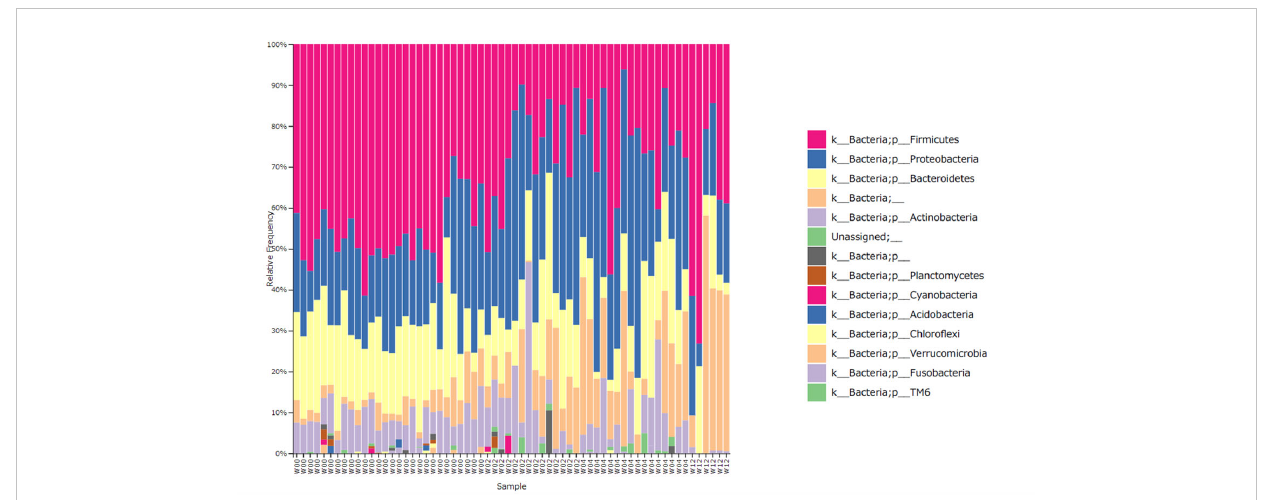
FIGURE 2 Relative abundance of the bacterial phylum level. W00, W02, W04, and W12 represent before operation and 2-, 4-, and 12-weeks after operation, respectively. The proportion of Firmicutes decreased and that of Proteobacteria increased with time. At 12 weeks post operation, some specimens showed a recovered proportion of Firmicutes.